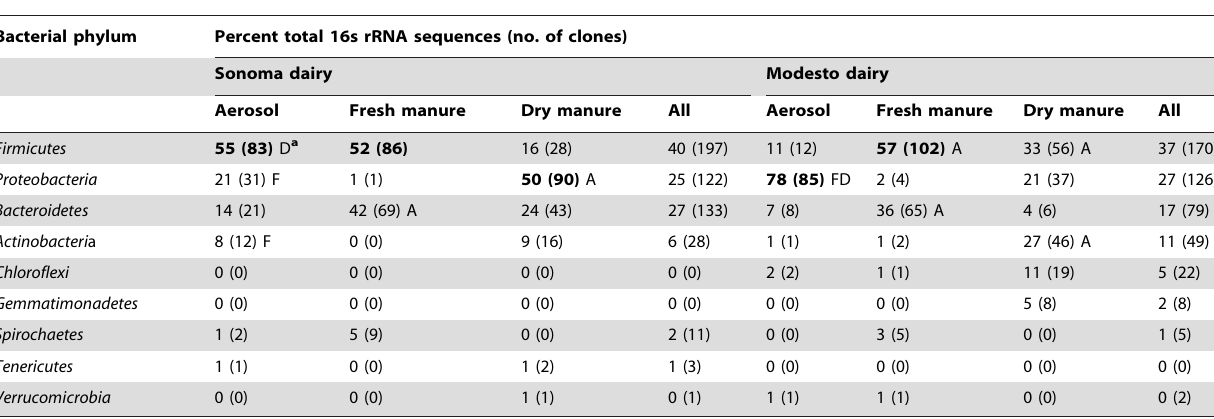
Table 1. Bacterial community dynamics of environmental samples collected from two dairies with distinct manure management practices.